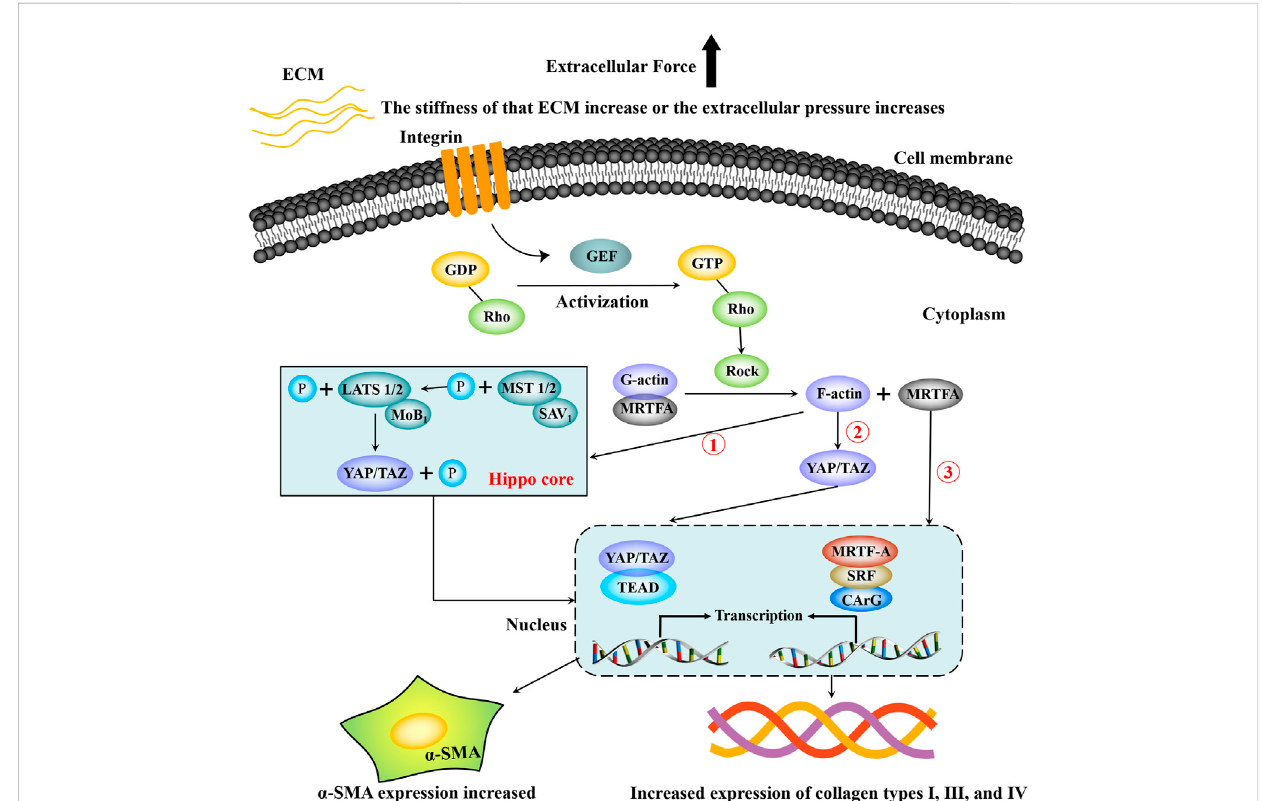
FIGURE 2 Partialmechanotransductionpathwaysintheprocessofhepatic fi brosis.Integrinsensesmechanicalsignalssuchasextracellularmatrixpressure,which can increase the guanylate conversion factor (GEF), and GEF promotes the phosphorylation of GDP-Rho to GTP-Rho, which promotes increased ROCK. Under thecontinuous action of ROCK, the complex composedof G-actin and MRTF-A dissociates, G-actin is convertedinto F-actin and re-rehearsed, and F-actin can directly activate YAP/TAZ to translocation into the nucleus. F-actin can also inhibit the phosphorylation of MST1/2, thereby blocking the phosphorylationofLATS1/2,resultingintheinabilityofYAP/TAZtobephosphorylatedanddegraded.ThenYAP/TAZaccumulatedinthecytoplasmentersthe nucleus and binds to TEAP, increasing thetranscriptional expression of target genes.In addition, dissociatedMRTF-A enters thenucleus and binds to serum response factor (SRF) and then activates target genes containing CArG elements to promote transcriptional expression of target genes. Finally, HSCs are activated and express a large amount of α -SMA and extracellular matrix components such as type Ⅰ , Ⅲ , Ⅳ